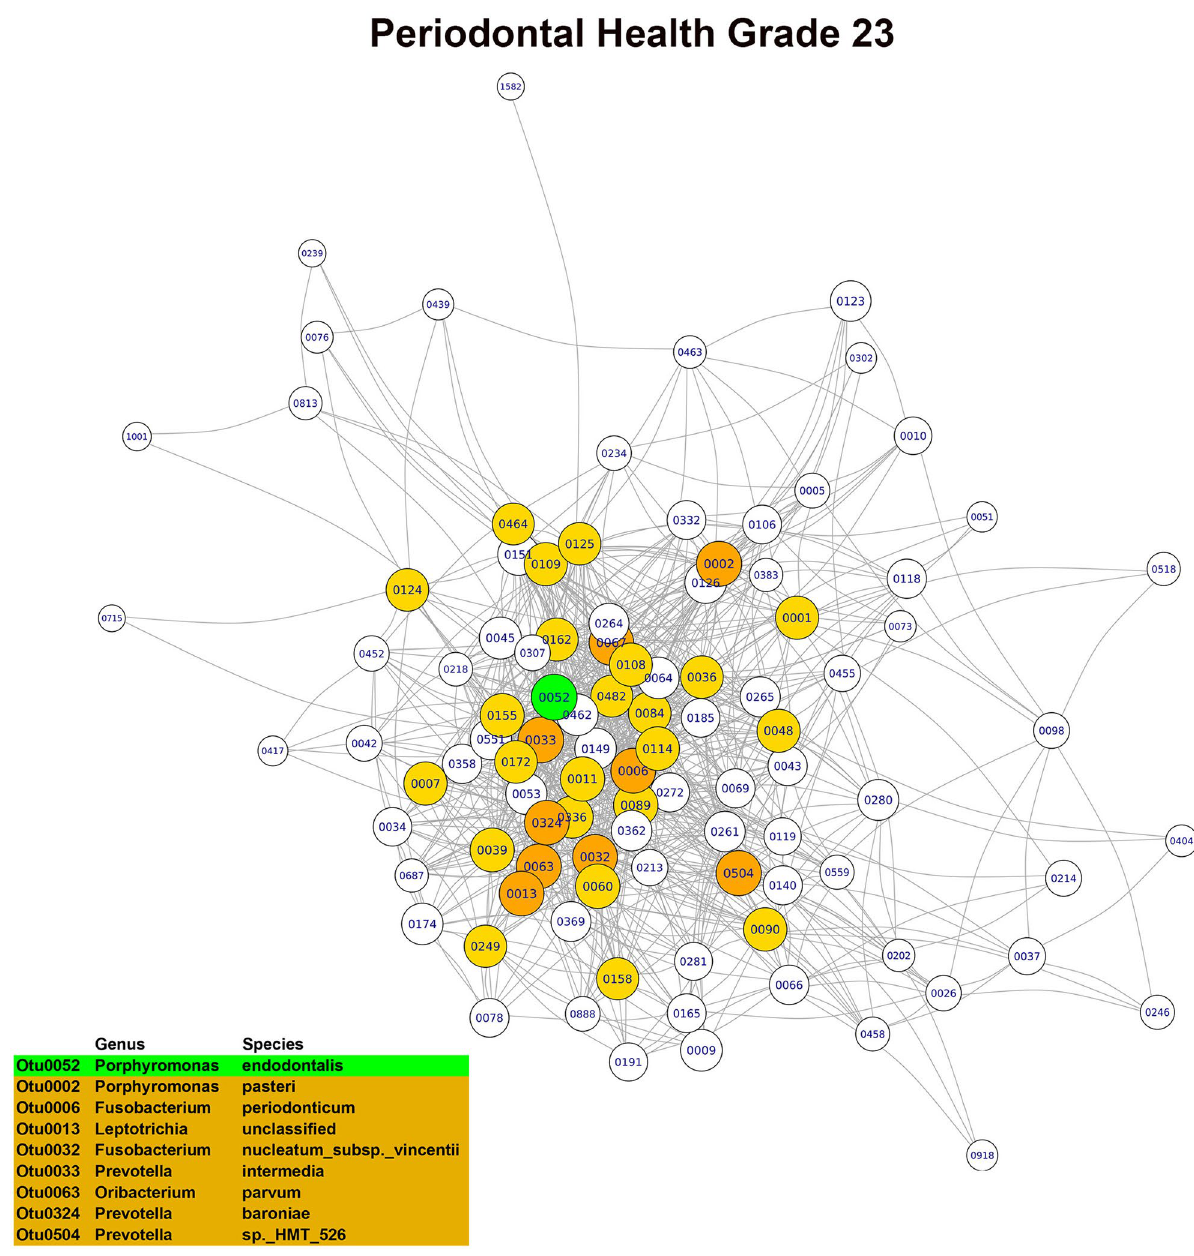
Figure 6. Main module of the co-occurrence network associated with grade 0 of the dental health subscale (node = 101; degree = 2663) (graphic made using the igraph package, version